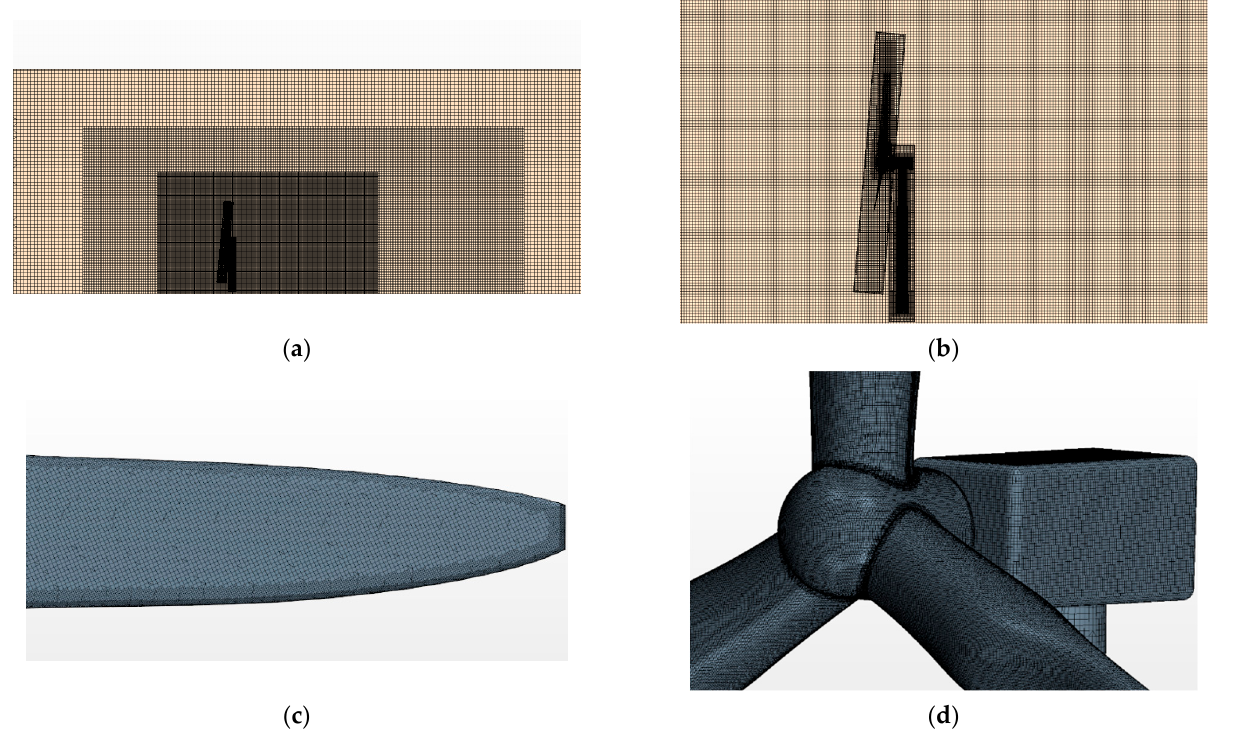
Figure 2. Simulated mesh in different parts. ( a ) The full fluid domain; ( b ) blade surface mesh; ( c ) overset mesh; ( d ) hub surface mesh.